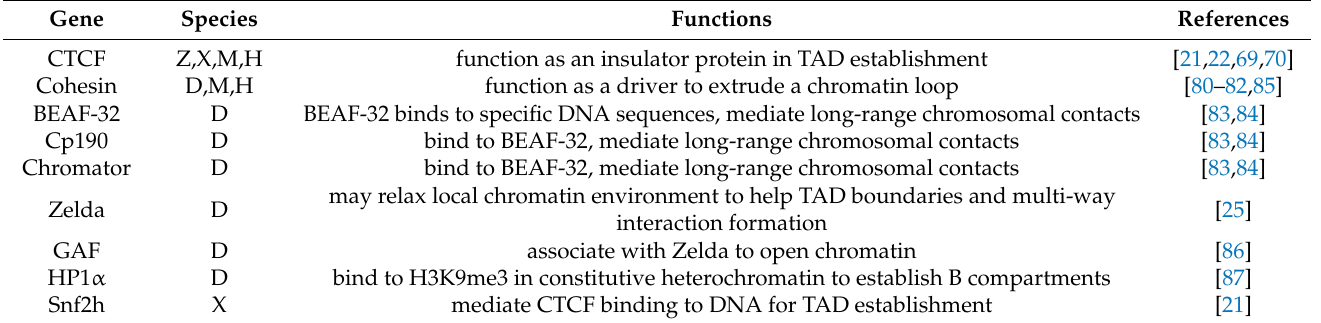
Table 1. Insulator and non-insulator proteins in domain formation. “D” for drosophila; “Z” for zebrafish; “X” for xenopus; “M” for mouse; “H” for